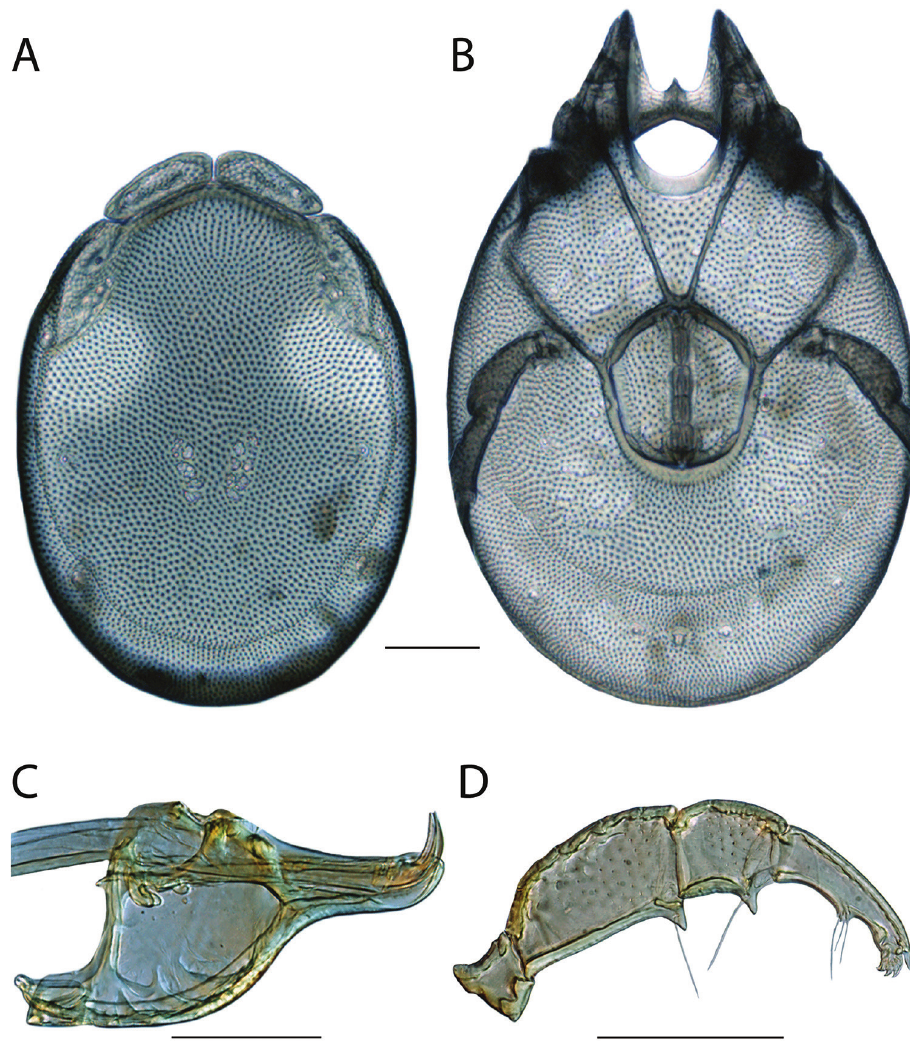
Figure 36. Torrenticola caerulea sp. n. female: A dorsal plates B venter (legs removed) C subcapitulum D pedipalp (setae not accurately depicted). Scale = 100